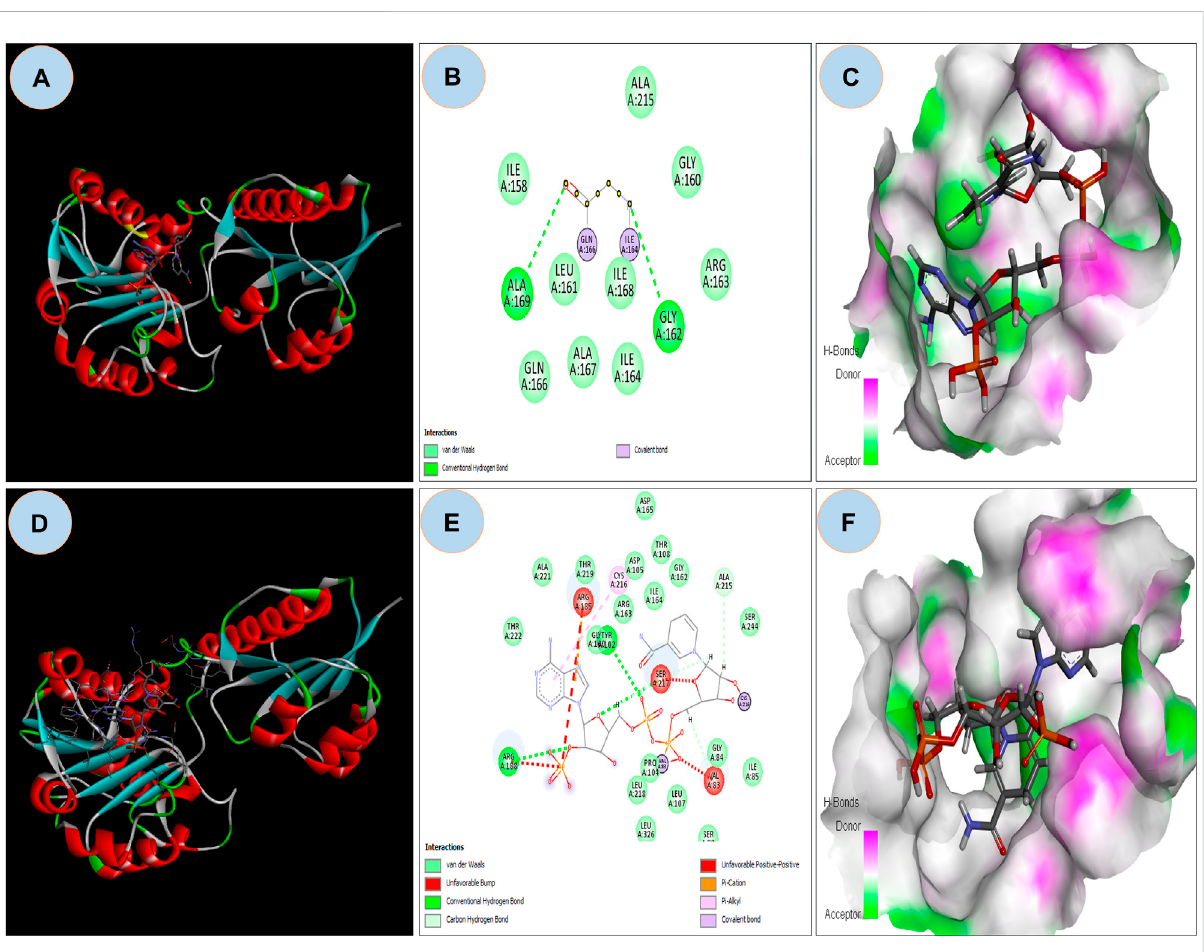
FIGURE 5 (A) Showing docking with NDP ligand on NAD binding domain on Wild GRHPR protein in 3D; (B) showing interactions of wild GRHPR protein withNDPligandin2D; (C) Enlarged viewoftheReceptorsiteofWildGRHPRproteinvs.NDPligandwrttoH-bondpocket; (D) Showing